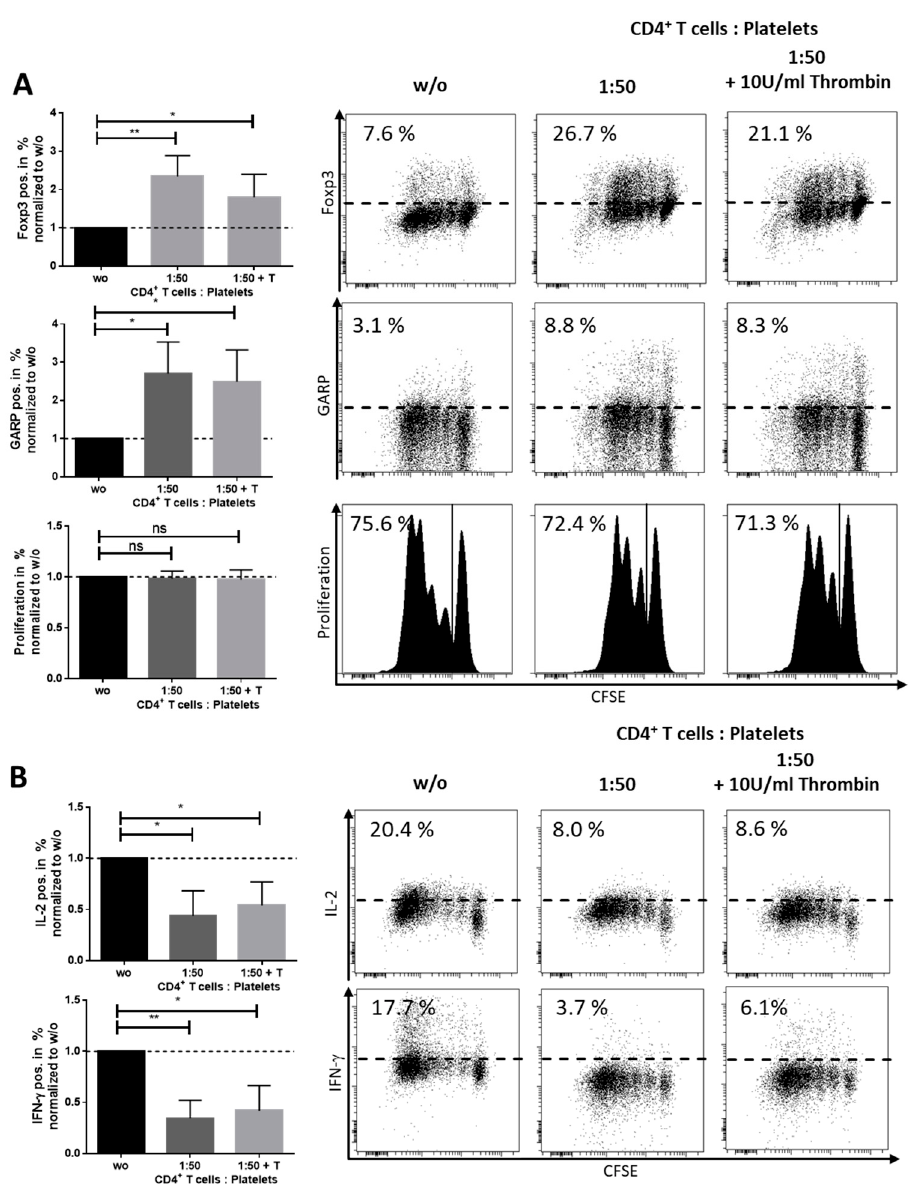
Figure A4. Thrombin-activated platelets induced a regulatory phenotype in CD4 + CD25 − T cells. 1 × 10 6 CD4 + CD25 − T cells were stimulated with 0.5 µg/mL anti-CD3 mAb and 1.0 µg/mL anti-CD28 mAb with or without 50 × 10 6 platelets for 6 days and treated with or without 10 U/mL thrombin. ( A ) Foxp3 and GARP expression and proliferation were determined at day 3 via flow cytometry. ( B ) Using intracellular flow cytometry, we analyzed cytokine production of IL-2 and IFN- γ on day 6. Dot plots show one representative result of five independent experiments ( n = 5, box and whiskers, medians ± min/max, * p < 0.05, ** p ≤ 0.01, and n.s. determined by one-way ANOVA).